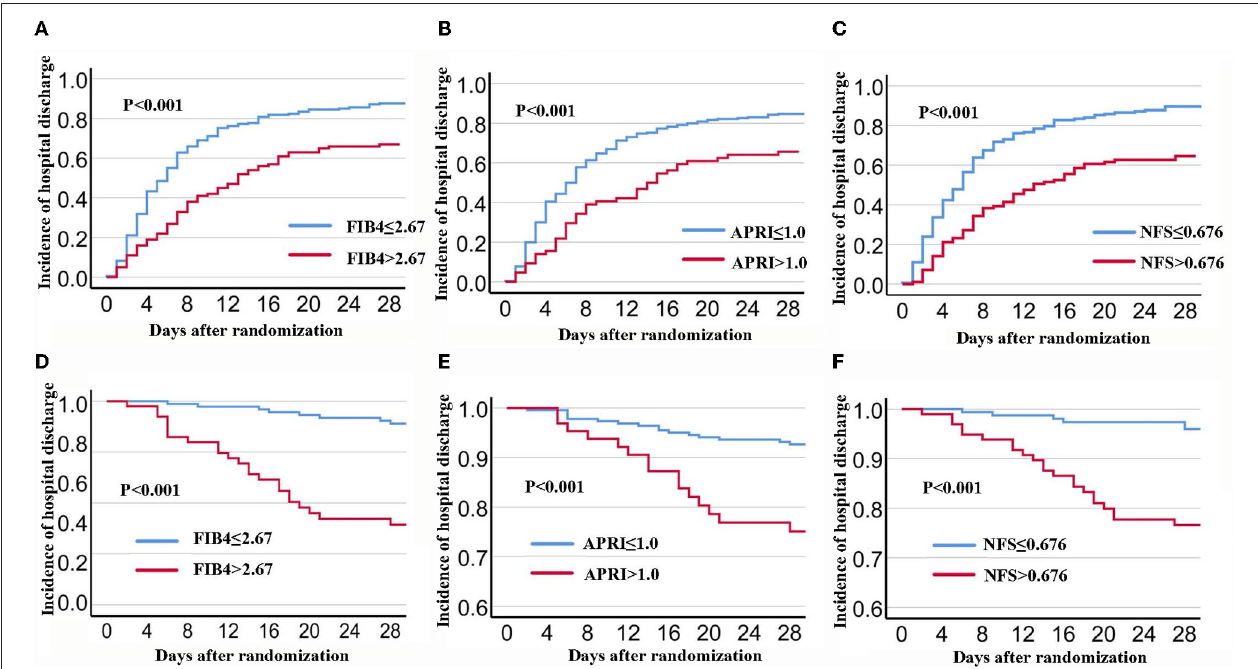
FIGURE 1 | K-M Survival curves for 28-days discharge and 28-days mortality stratified by FIB-4, APRI, and NFS in patients with COVID-19. (A,D) : FIB-4; (B,E) : APRI; (C,F) : NFS. FIB-4, Fibrosis-4; APRI, Aspartate Aminotransferase -to-platelet ratio index; NFS, NAFLD fibrosis score.